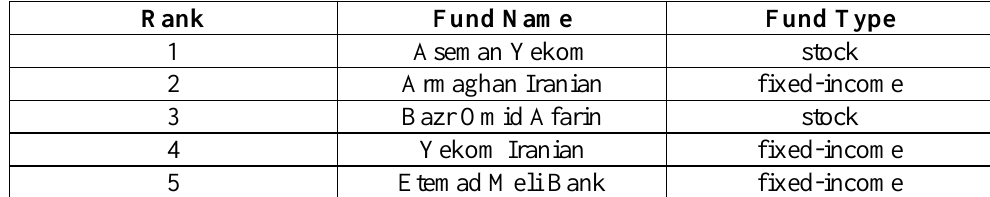
Table 3. Five Systemically Important Funds in the Late September 2019